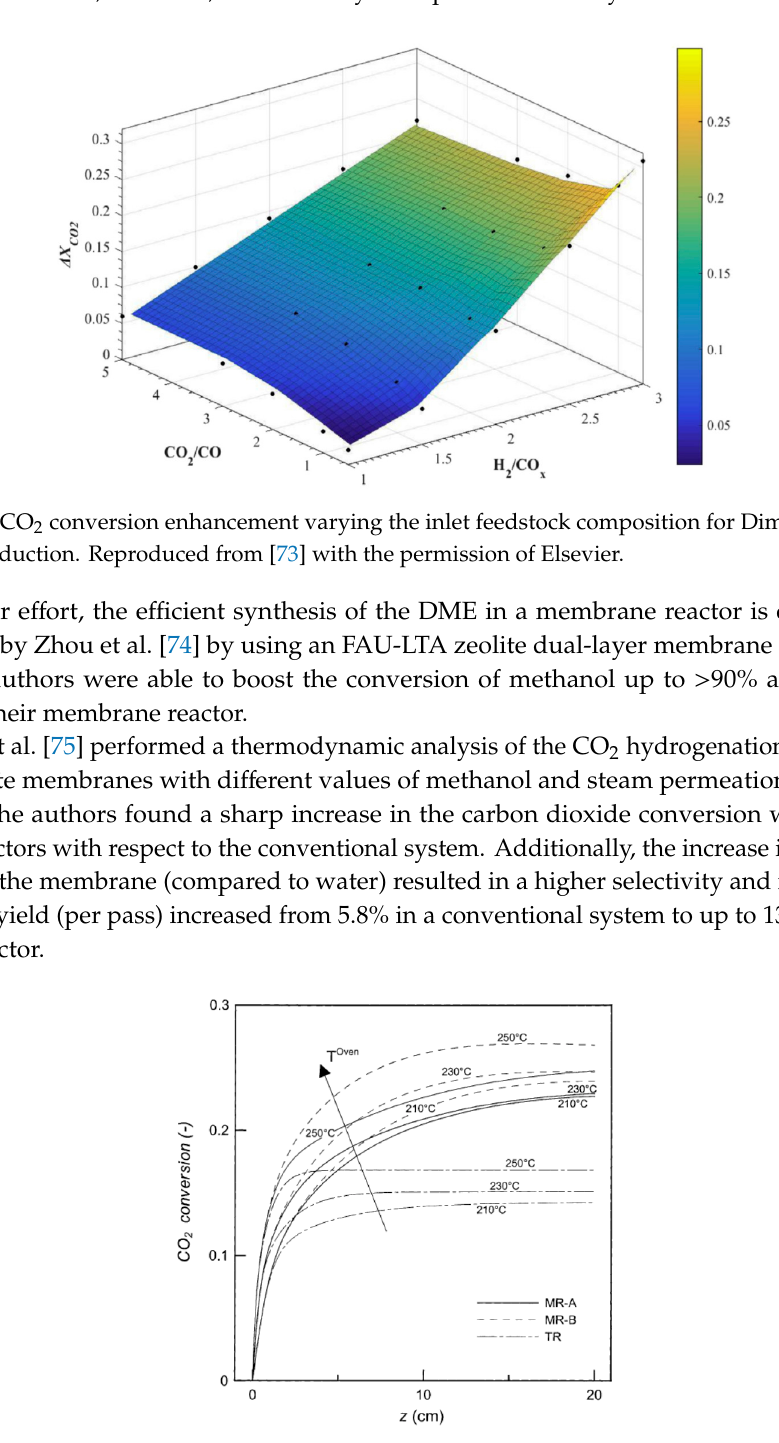
Figure 15. CO 2 conversion profiles for MR and TR at oven temperatures of 210, 230, and 250 ◦ C. Feed flow rate, 400 cm 3 (STP) / min; sweep gas flow rate = 1000 cm 3 (STP) / min; H 2 / CO 2 feed molar ratio = 3, P Reaction = P Permeation = 10 bar. Reproduced from [75] with the permission of